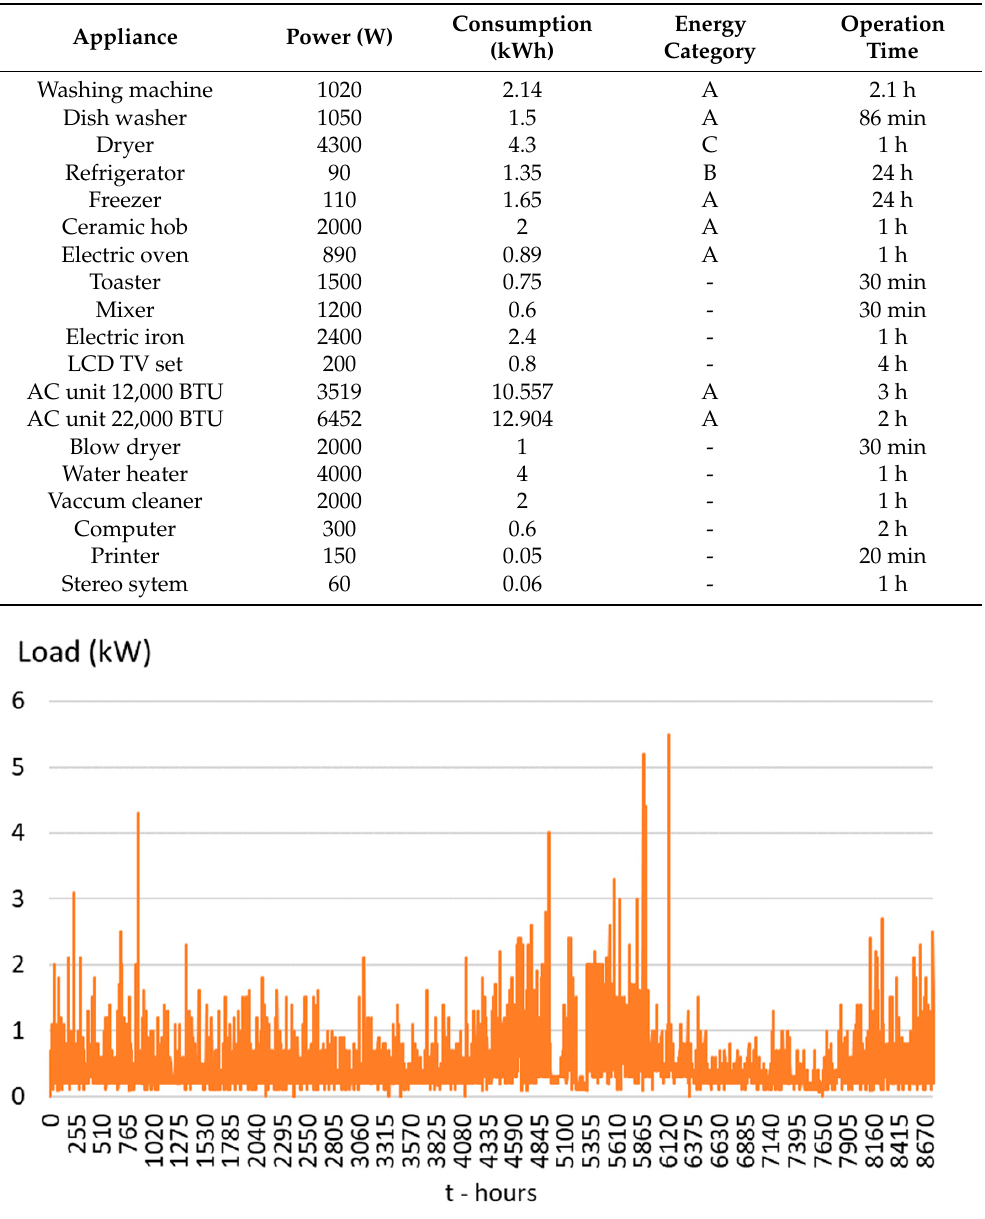
Table 2. The overall space heating needs are covered by a Diesel boiler. The measured hourly consumption ( P D ) for the whole year is depicted in Figure 3. Table 2. Consumption and usage of the considered appliances.